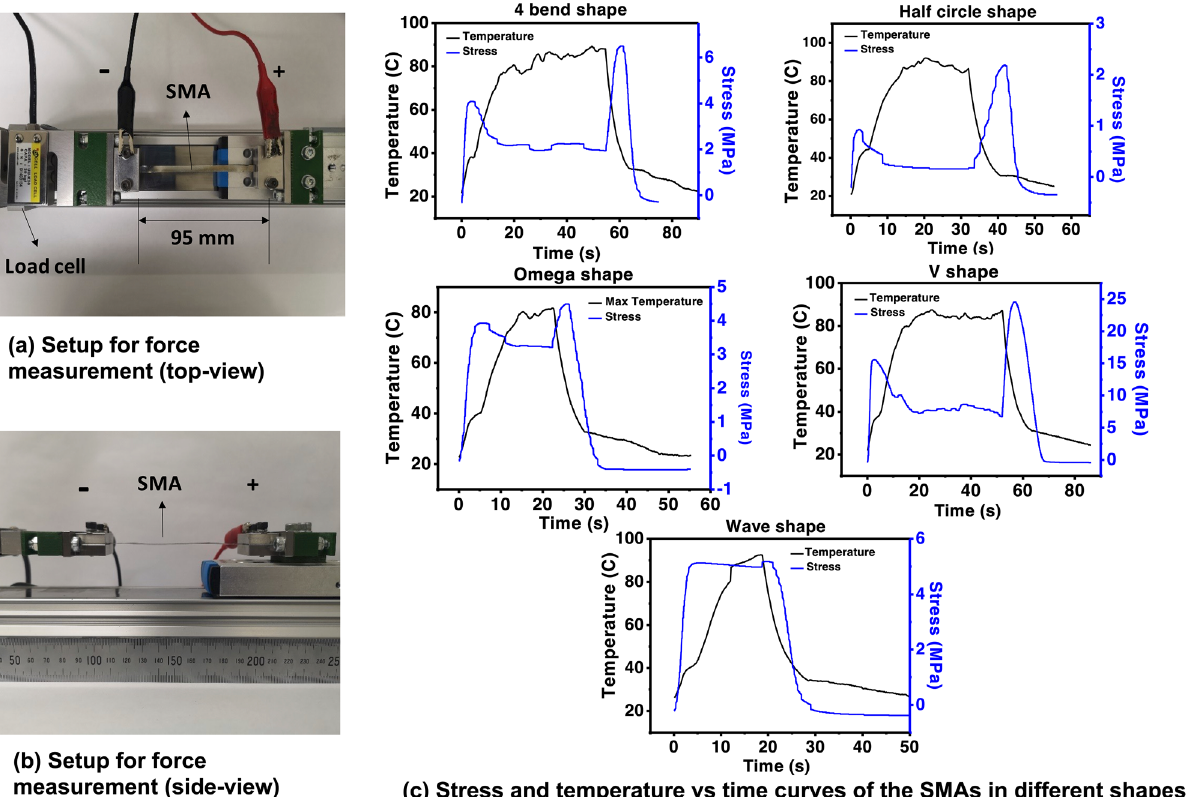
Figure 3. Setup of the force measurement (a) top-view and (b) side-view. (c) Shows the stress and temperature characteristics curves for the five SMA